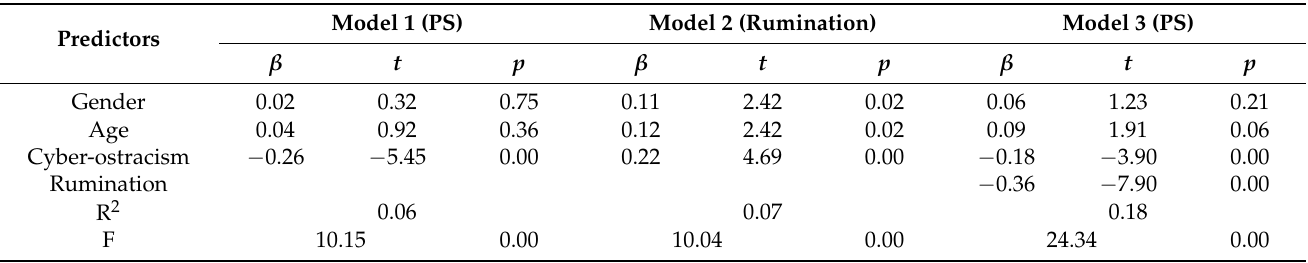
Table 2. Examining the mediation effect of cyber-ostracism on psychological